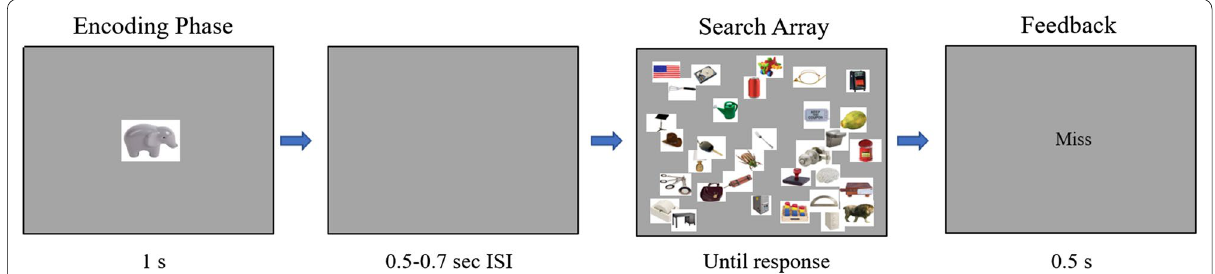
Fig. 1 Layout of an uninterrupted trial. During uninterrupted trials, search was not suspended by the interruption task. For demonstration purposes, the schematics throughout the paper contain less than 150 distractors and do not show the “absent box”